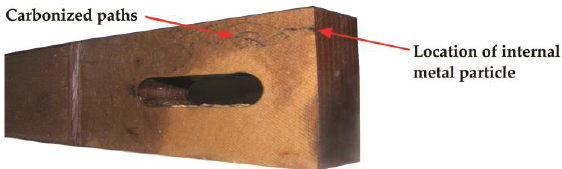
Figure 2. The location of an embedded metal particle under the surface of pressboard beam (the PD tracking originated from this area).